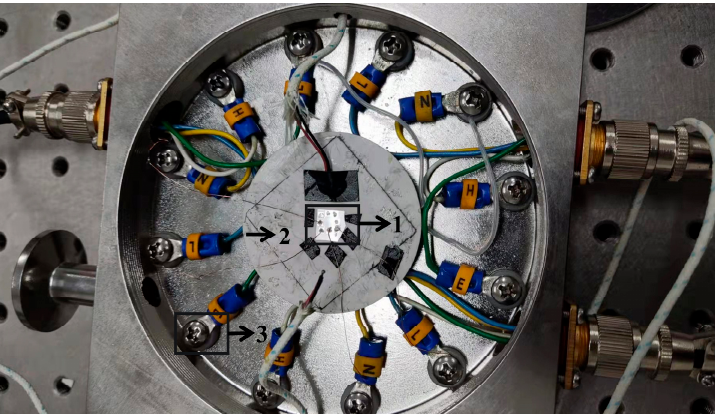
Figure 3. Constant temperature vacuum chamber. (1—sensor, 2—constant temperature heating plate,